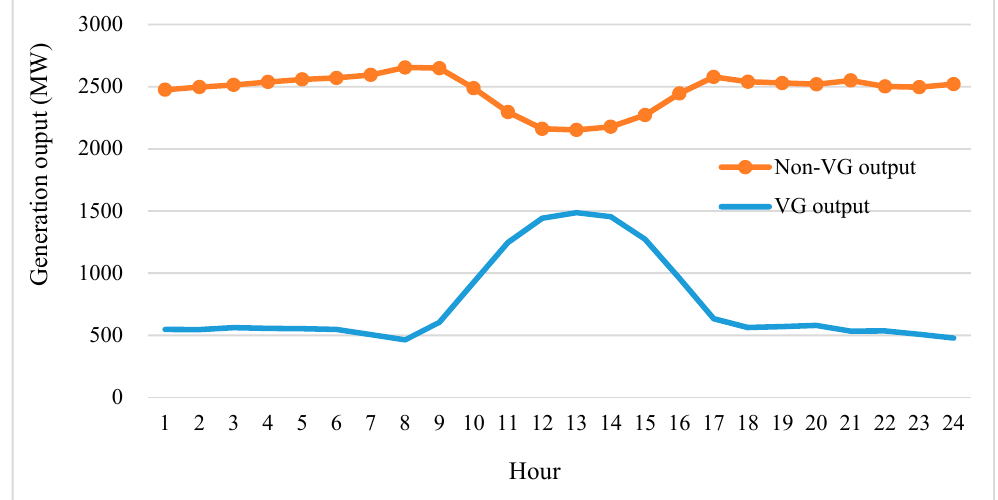
Figure 3. VG/Non-VG output profiles of peak day in 2016.